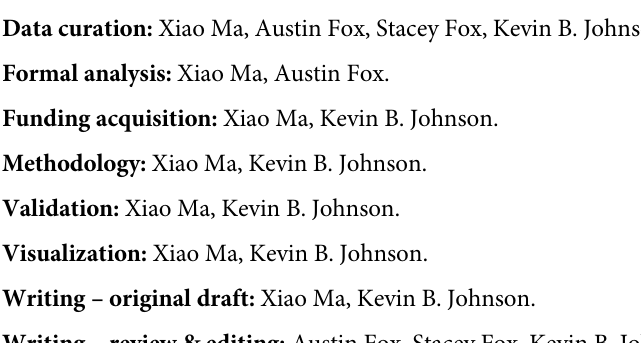
S1 Fig. Fine-grained organic-rich sediments (FGORS) survey locations (black dots) in A) the control canal, and B) the aeration canal. The maps were generated from ArcGIS Online base- map [43]. S2 Fig. Two-dimensional nMDS ordination plots of surface vs. bottom planktonic assem- blages in aeration canal (A1, A2), control canal (C1, C2) and Grand canal (CM, AM) in differ- ent months. S1 Table. Raw cell density (cells ml -1 ) of phytoplankton in each sample. S2 Table. Raw data of environmental parameters in each